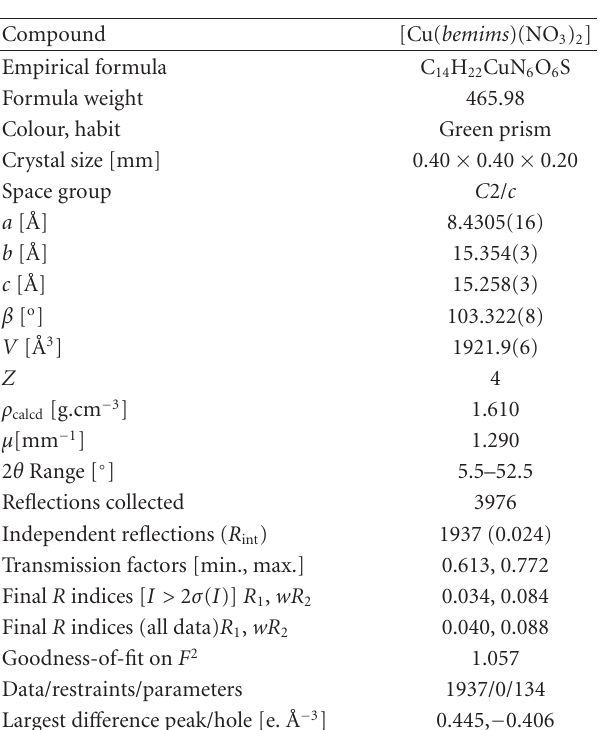
Table 1: Crystallographic Data for [Cu( bemims )(NO 3 ) 2 ].